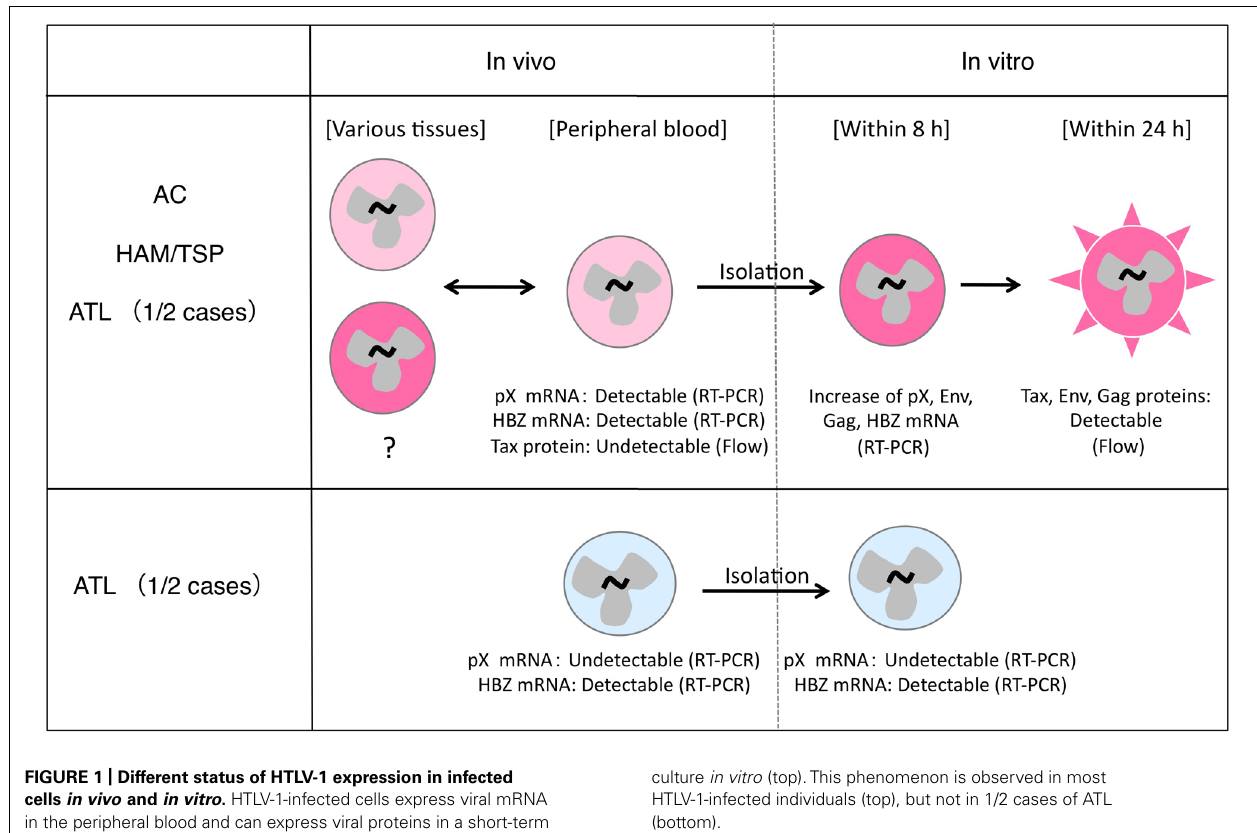
FIGURE 1 | Different status of HTLV-1 expression in infected cells in vivo and in vitro . HTLV-1-infected cells express viral mRNA in the peripheral blood and can express viral proteins in a short-term